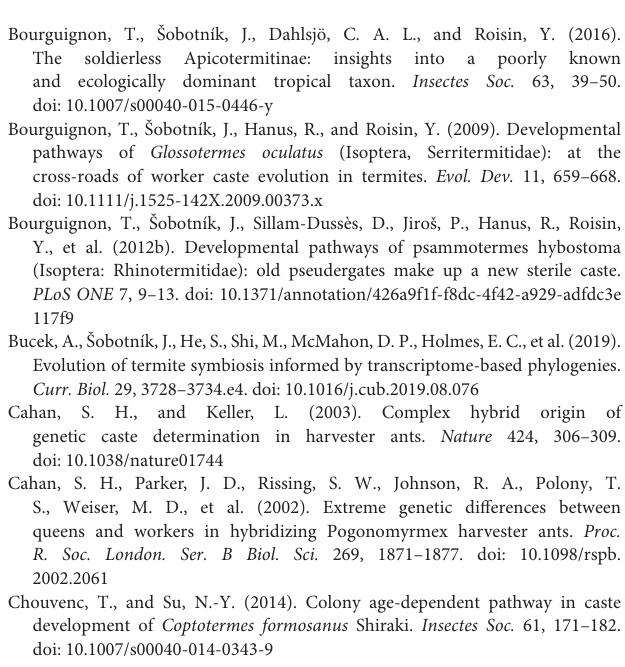
Table S1 | Termite potency descriptions. Table S2 | Termite potency categorizations. Table S3 | Bibliography of termite potency